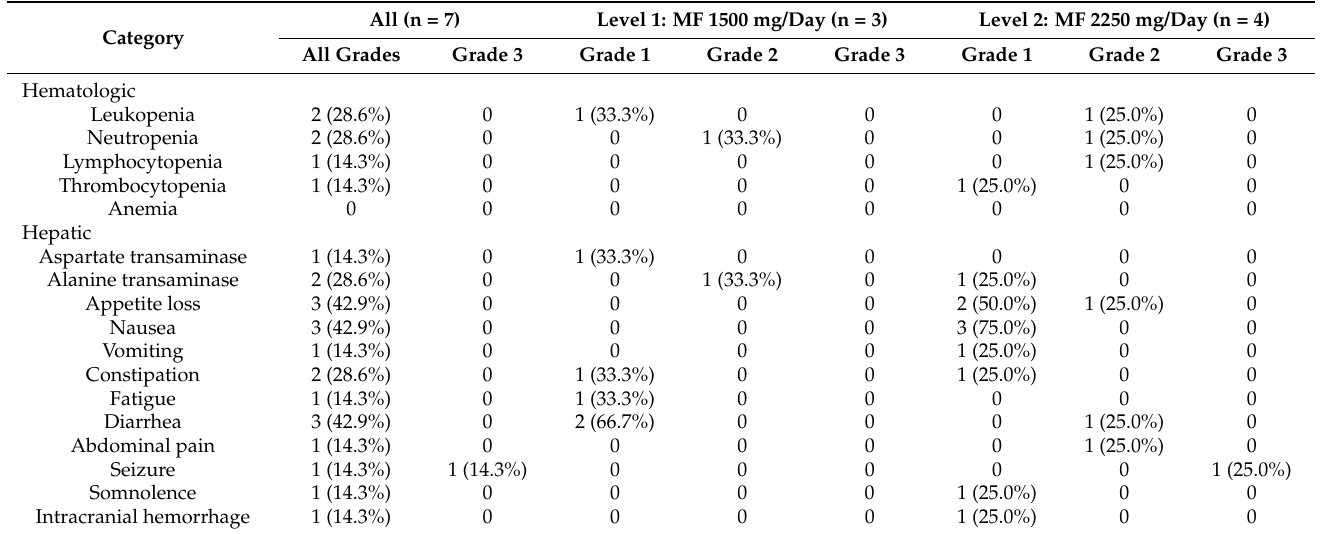
Table 3. Adverse events of any